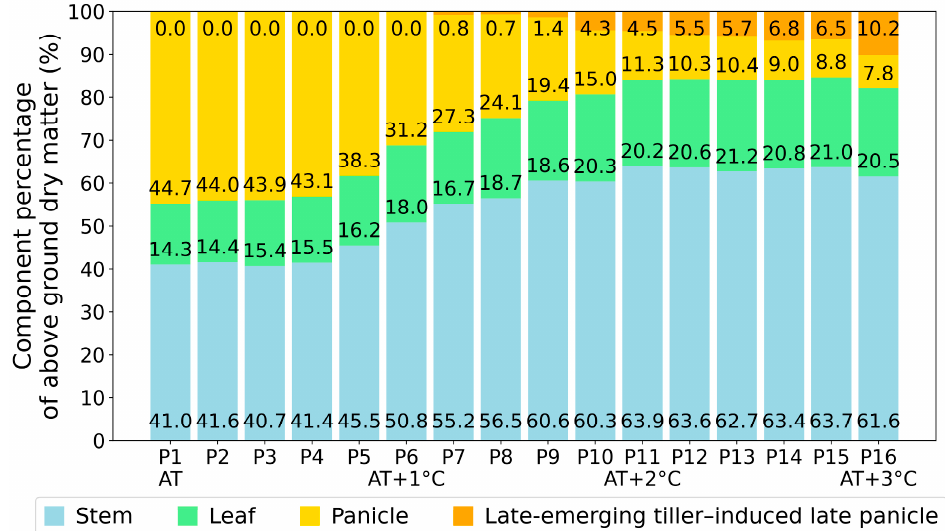
Figure 5. Component percentage of above ground dry matter (AGDM) depending on heat stress. The survey positions were expressed as P1 to P16. P1 indicates a position at ambient temperature (AT) and P16 indicates a position at AT+3 °C.